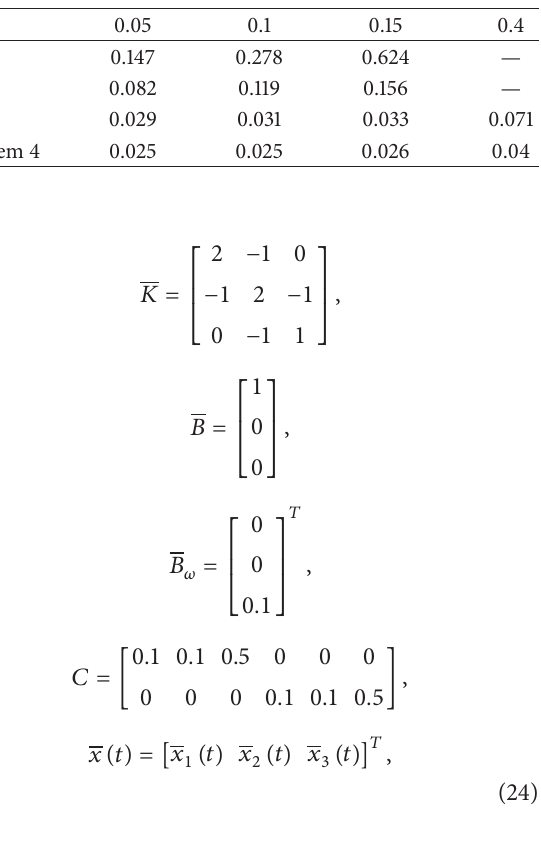
Table 1: Minimum feasible disturbance attenuation 𝛾 by different input time delay 𝑑 .